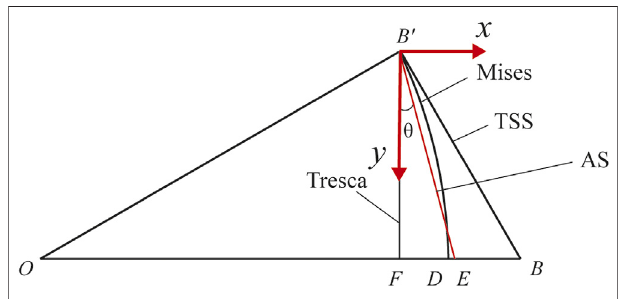
FIGURE 2 | The geometry of the average slope yield